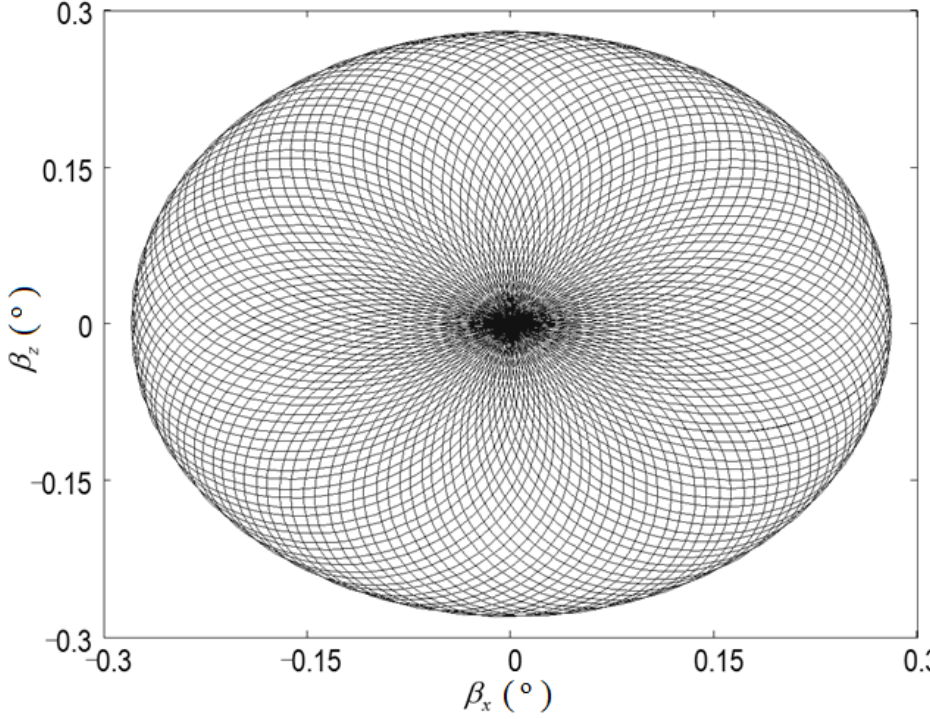
Figure 5. The area of scanned airspace in the second operating mode of the seeker.